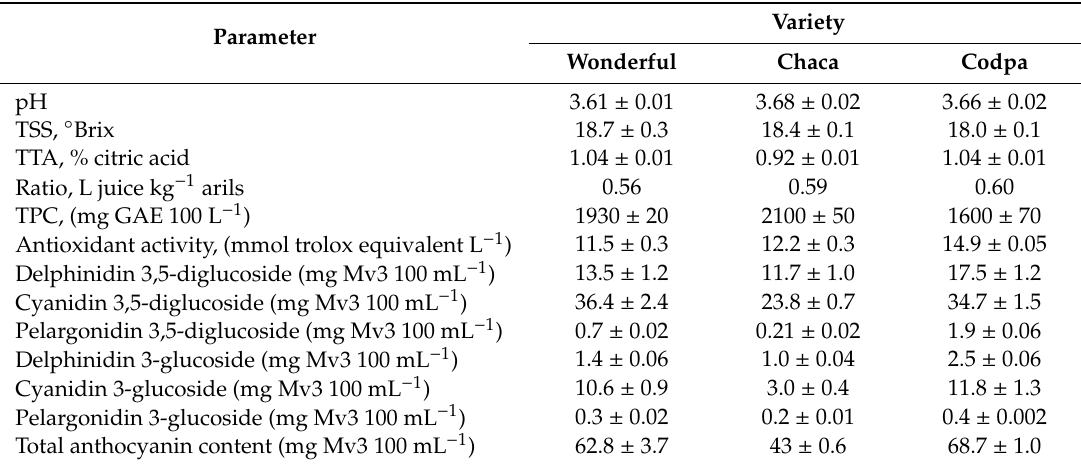
Table 1. Pomegranate juice composition from three varieties (Wonderful, Chaca and Codpa) at full ripe stage (adapted from